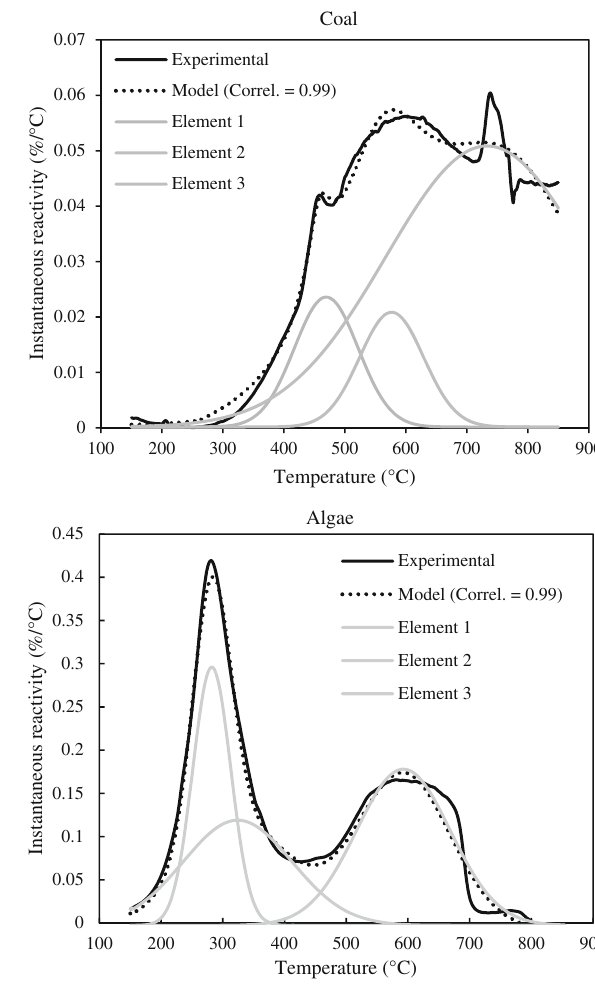
Fig. 1 Mass-loss and DTG curves for coal, algae and their blends Fig. 2 Experimental and model DTG plots for coal and algae (with deconvoluted plots for constituent compounds) at 10 (cid:3)